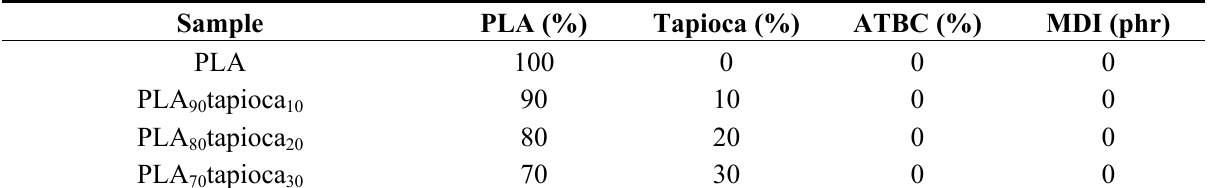
1. Compositions of PLA, PLA (PLA tapioca MDI) ATBC specimens. x y a b Sample PLA (%) Tapioca (%) ATBC (%) MDI (phr) PLA 100 PLA tapioca 90